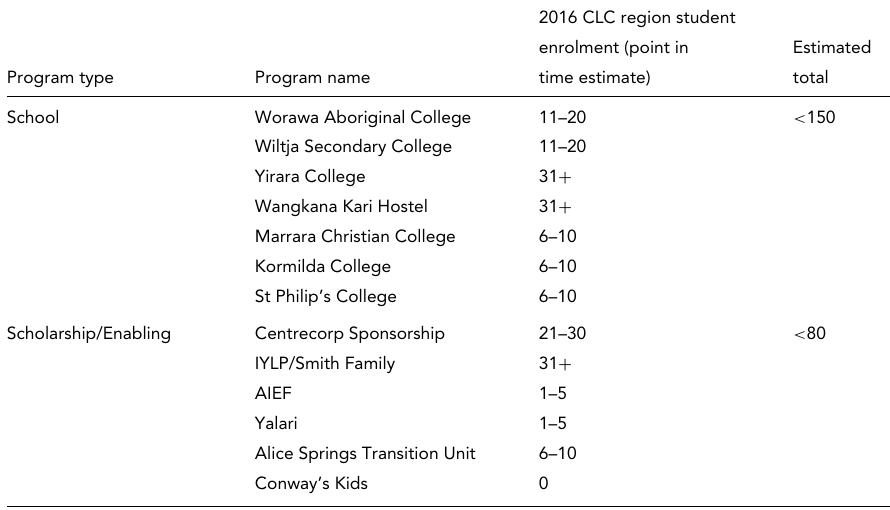
CLC Region Point in Time Boarding Enrolment Estimates by Program